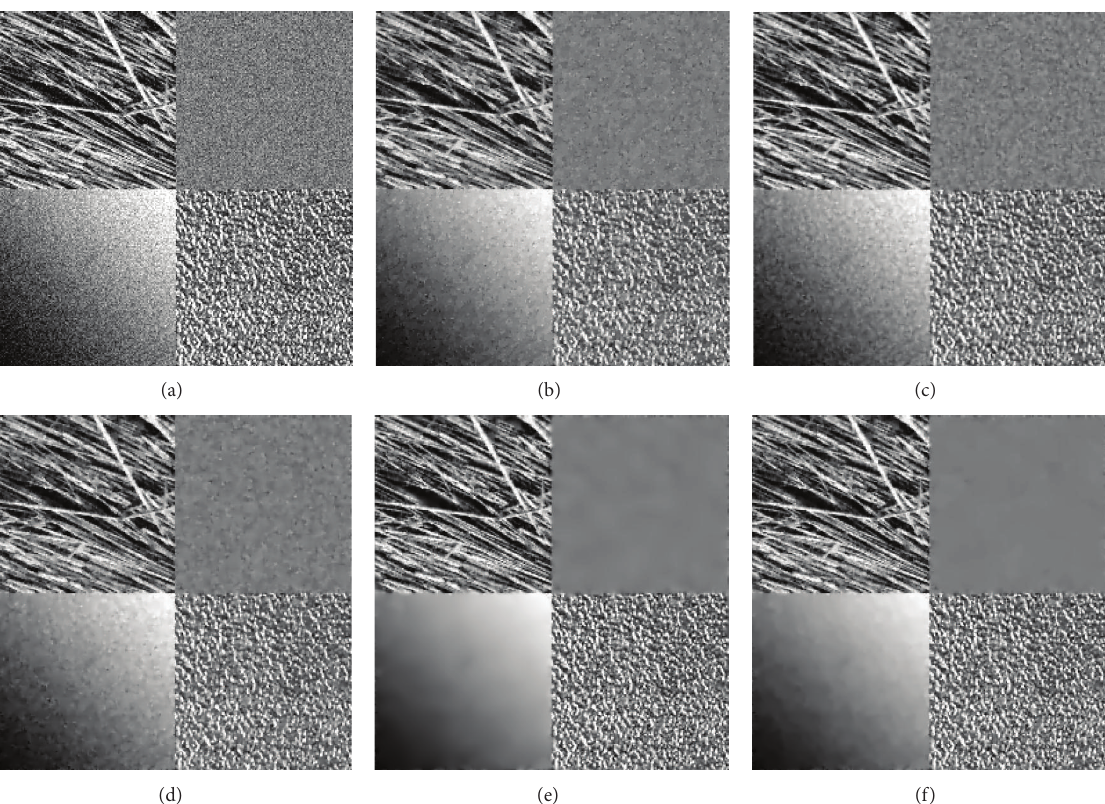
Figure 4: Results of different models for the synthetic image 2: (a) the noisy image, the restored images by (b) the ROF model, (c) the LLT model, (d) the hybrid model, (e) our Model 1 ( 𝛼 = 0.21 and 𝑟 = 7 ), and (f) our Model 2 ( 𝛼 = 0.35 and 𝑟 = 7 ).